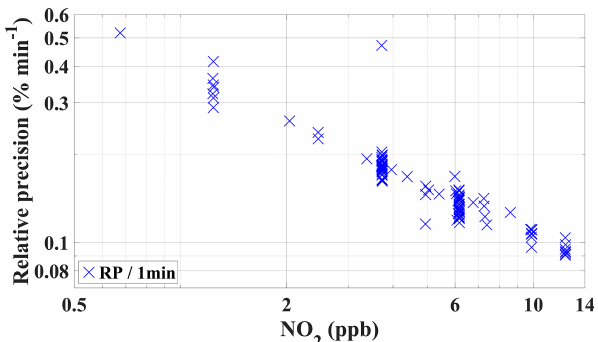
Figure 8. The relative 1min precision of GANDALF is shown for PARADE 2011 as a function of NO 2 mixing ratios. The relative precision is calculated from randomly selected PMT signals during different calibration periods.